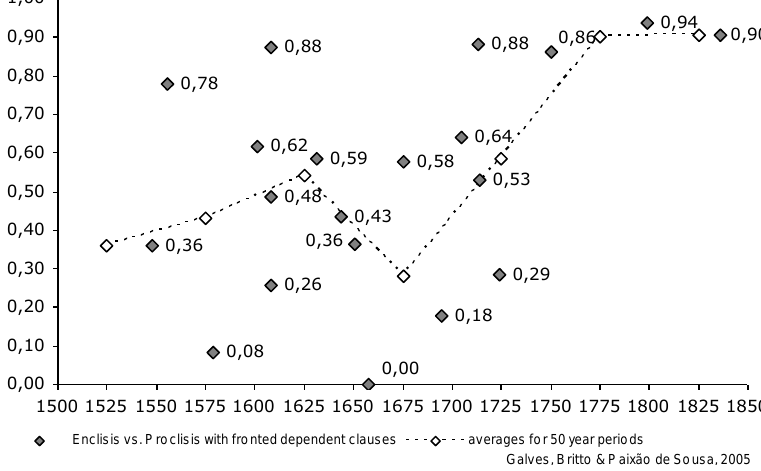
Enclisis vs. Proclisis with fronted dependent clauses averages for 50 year periods